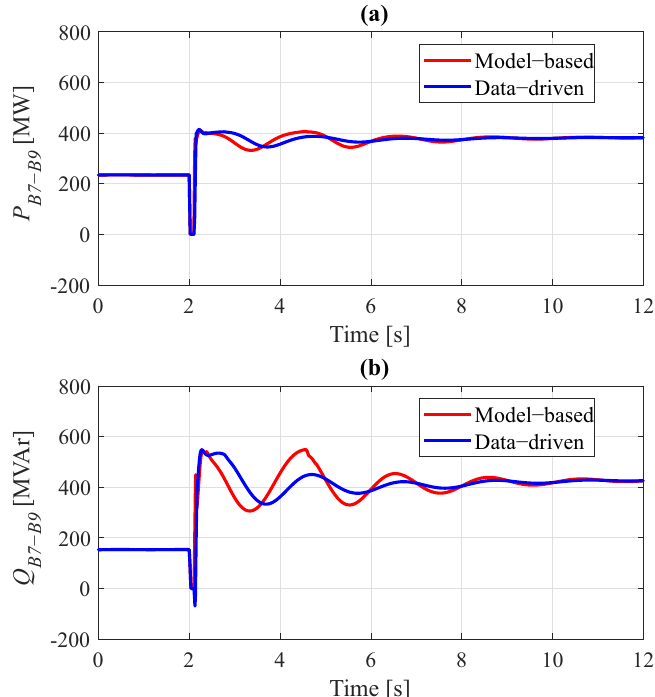
Figure 13. Power flows during transient fault and topology change: ( a ) active power, and ( b ) reac- tive power.